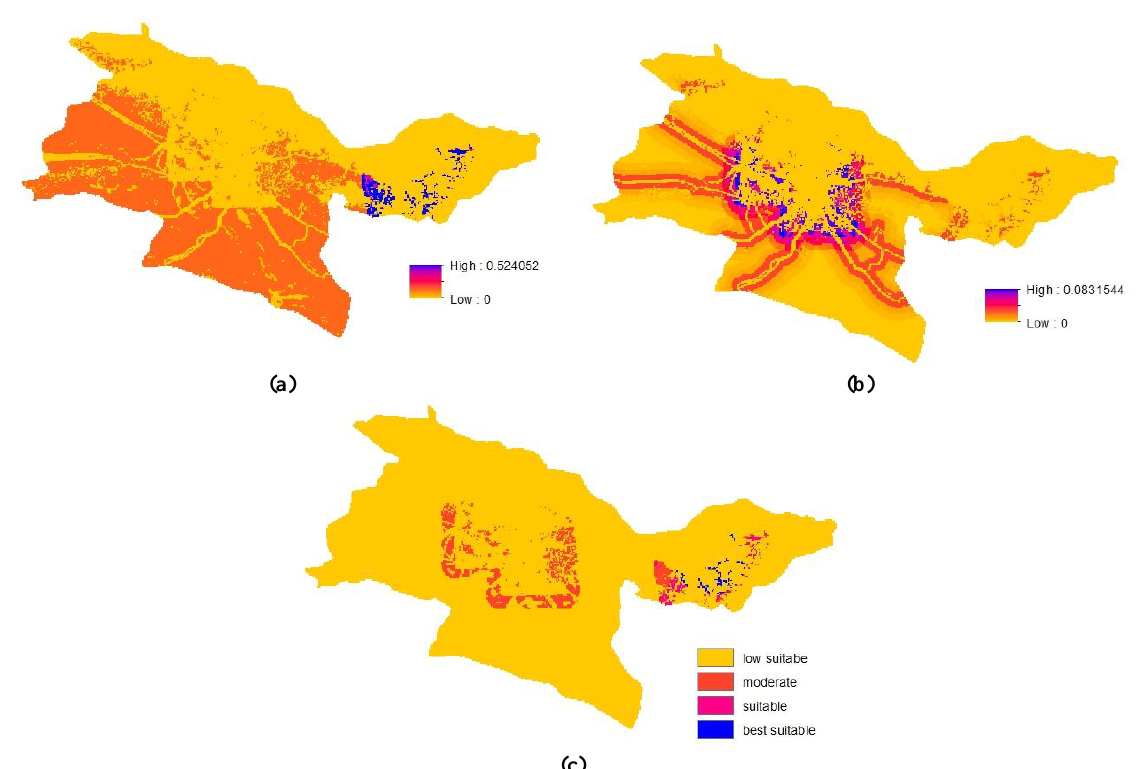
Figure 5. LSI for (a) environmental (b) economic factors. (c) final suitability map for wind turbine site selection.